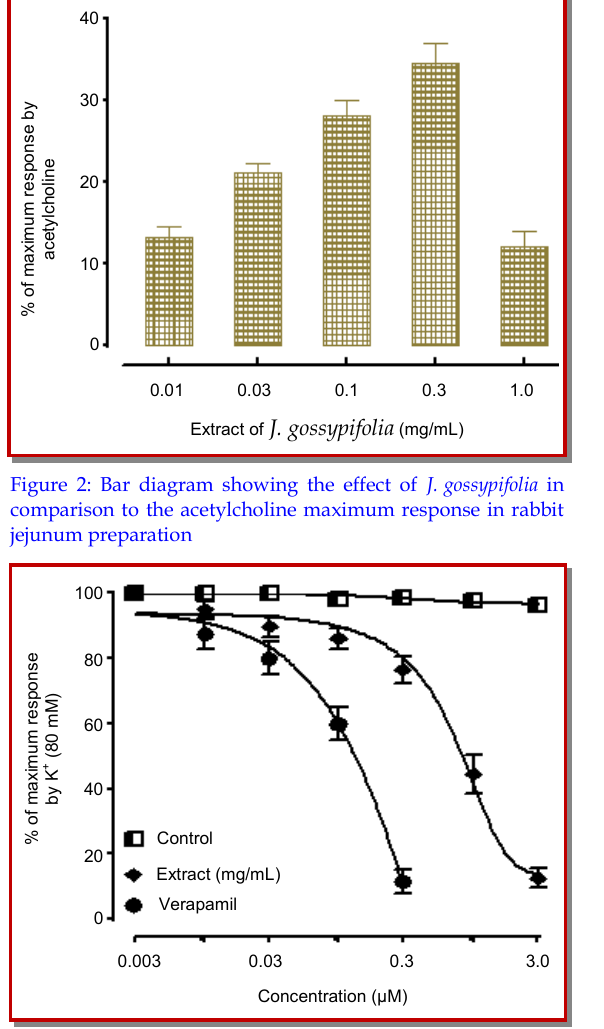
Figure 3: Concentration-dependent inhibitory effect of J. gossy- pifolia and verapamil against K + (80 mM)-induced contractions in isolated rabbit jejunum preparations (values are expressed as mean ± SEM, n=3)